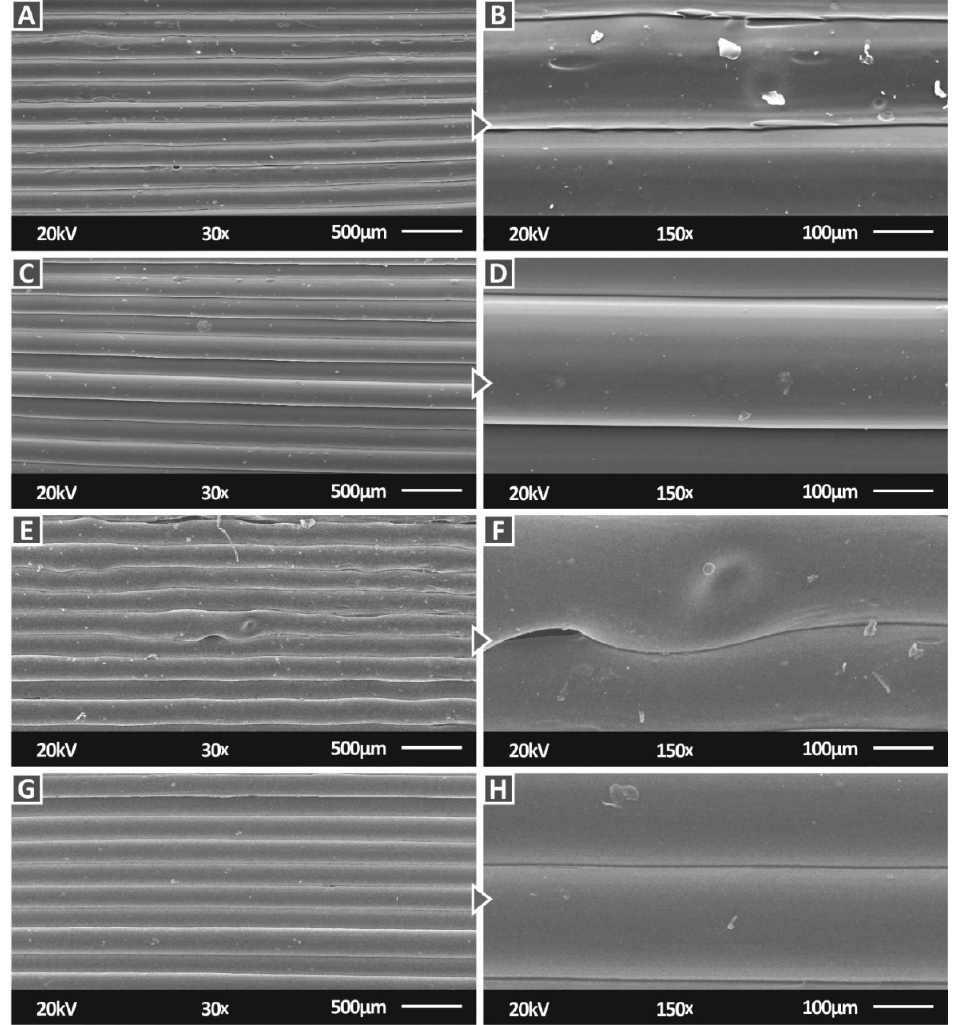
Figure 14. SEM images of the PC/TiC nanocomposites side surface: ( A ) 1 wt.% at 30×, ( B ) 1 wt.% at 150×, ( C ) 2 wt.% at 30×, ( D ) 2 wt.% at 150×, ( E ) 3 wt.% at 30×, ( F ) 3 wt.% at 150×, ( G ) 6 wt.% at 30×, and ( H ) 1 wt.% at 150×.